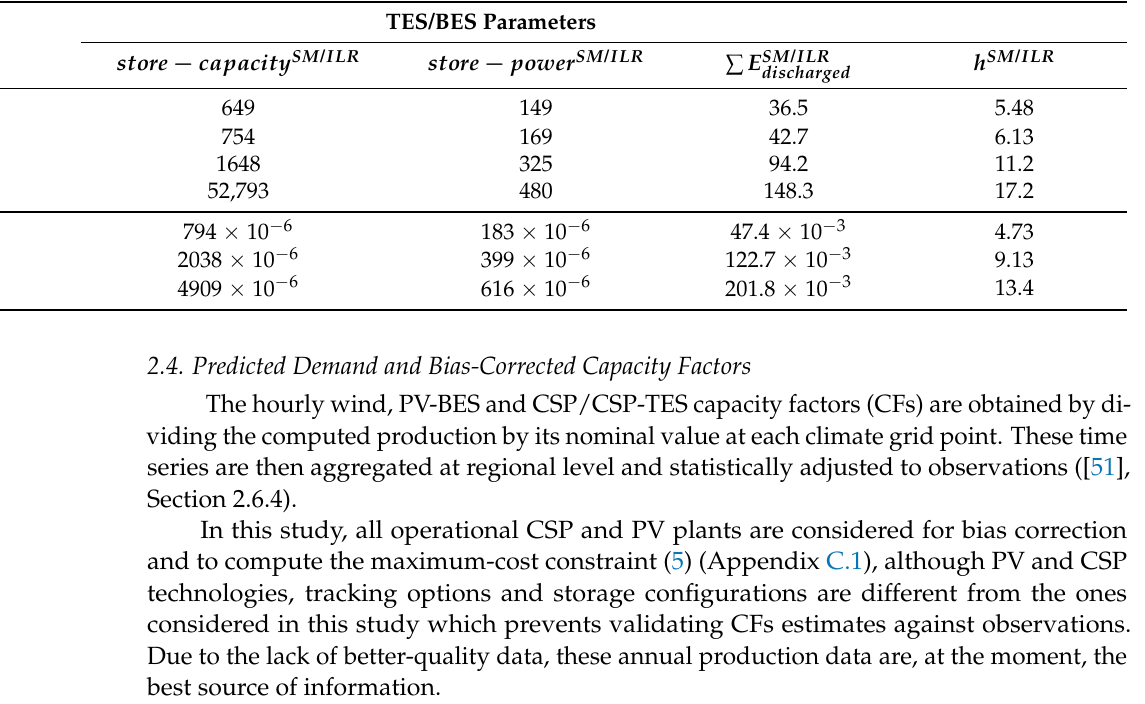
Table 1. Storage parameters: Storage capacity (MWh) (first column), Maximum power of charging/discharging (MW) (second column), Total energy discharged (TWh) (third column) and Storage duration (h/day) (fourth column) obtained for TES and BES model without constraints (Appendix B).